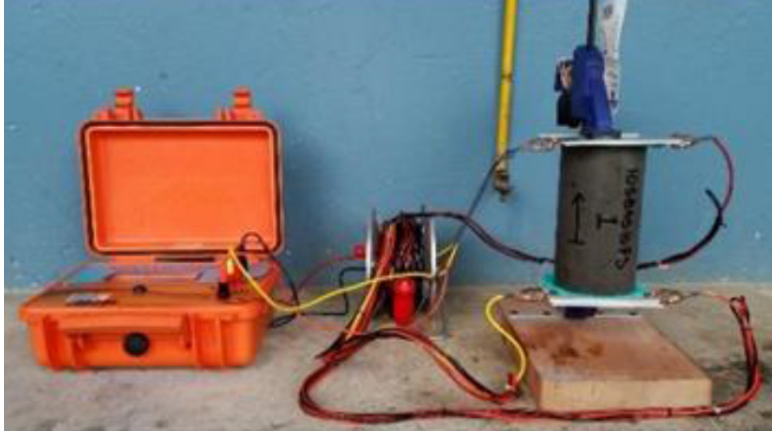
Figure 4. Characteristics of the electrical resistivity test. Table 4. Electrical resistivity in concrete and risk of corrosion [20].